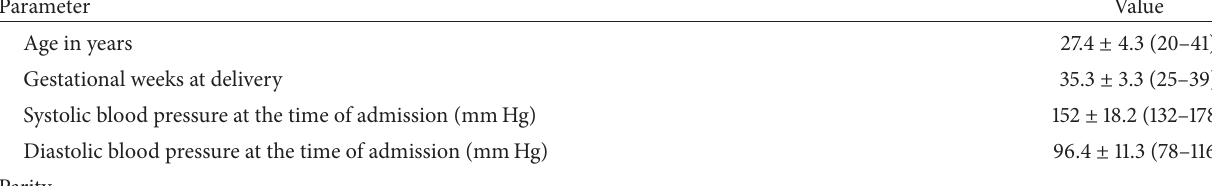
Table 1: Baseline clinical characteristics of study